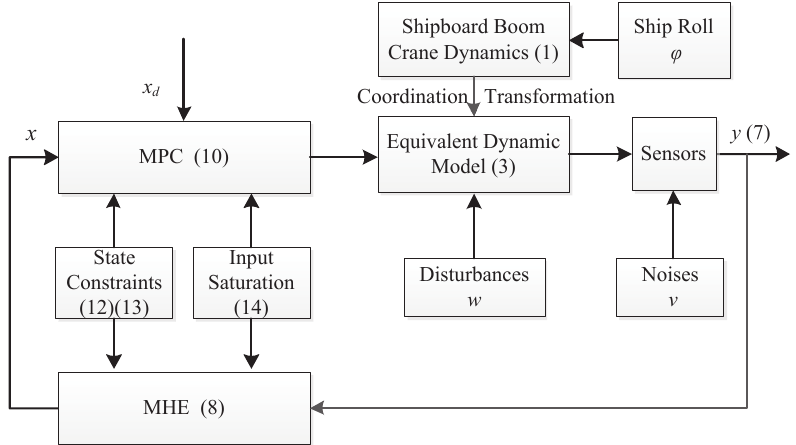
Figure 3. Block diagram of the control scheme combining MPC and